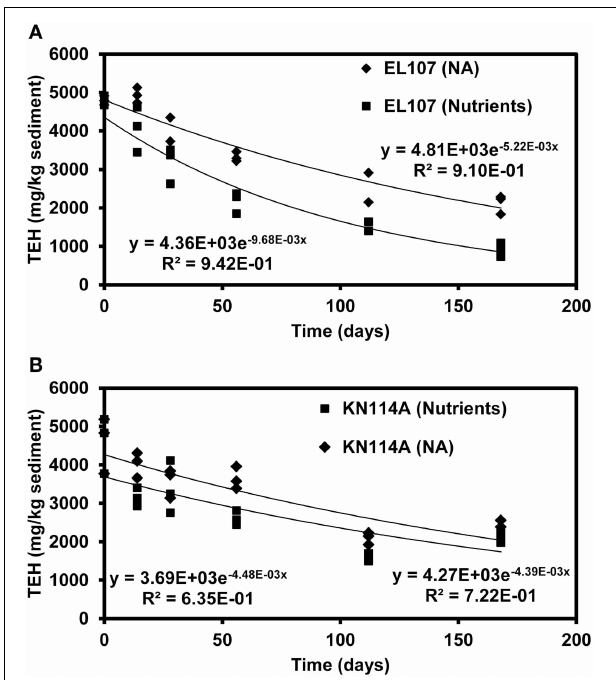
FIGURE 9 | Decrease of TEH (total extractable hydrocarbon) as function of time in (A) the EL107 and (B) KN114A microcosms along with fitted exponential decay curves. Diamond symbols = Natural attenuation, and square symbols = Nutrient amended. FIGURE 10 | Hopane concentration normalized by the concentration of